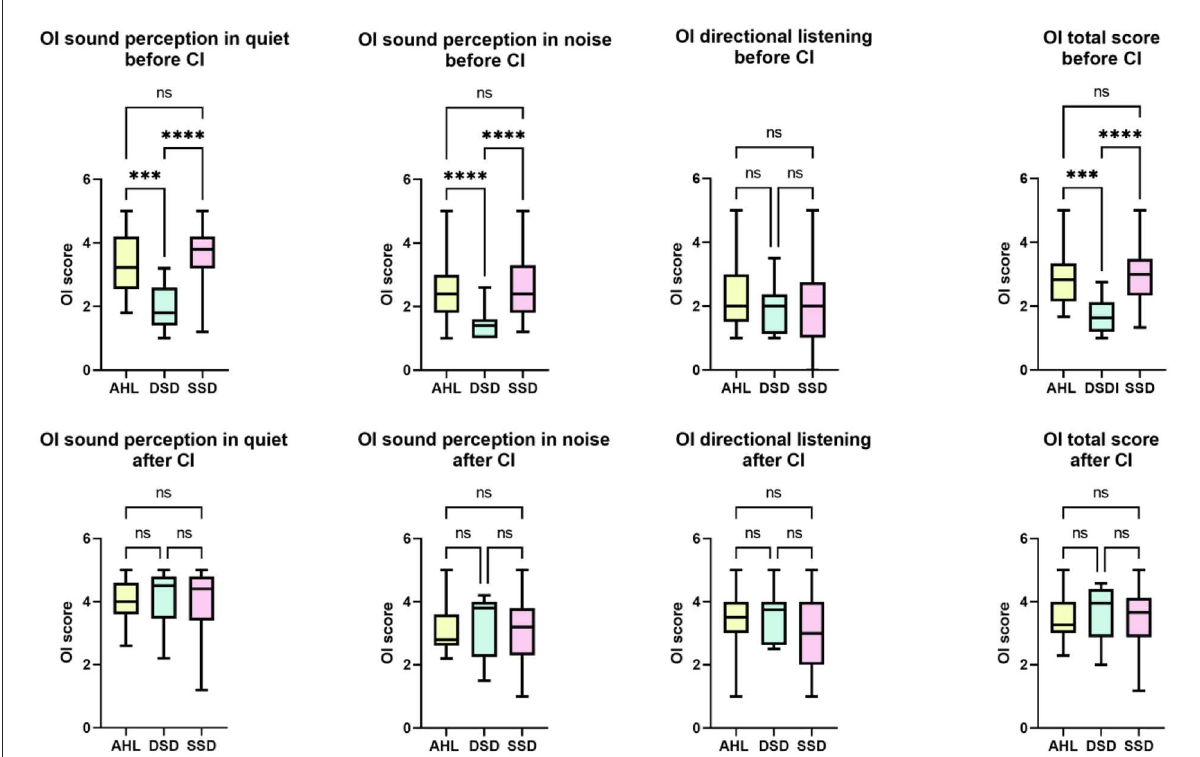
FIGURE4 Between-group differences in the self-reported quality of hearing before and after CI. The sound perception in quiet and noise, as well as the total score of the Oldenburg Inventory, differed between AHL and DSD and SSD and DSD but not AHL and SSD before implantation. The DSD group scored poorer than the other two. Six months after the activation of CI, there were no longer differences between the groups. *** p < 0.001. **** p = 0.0. ns, not